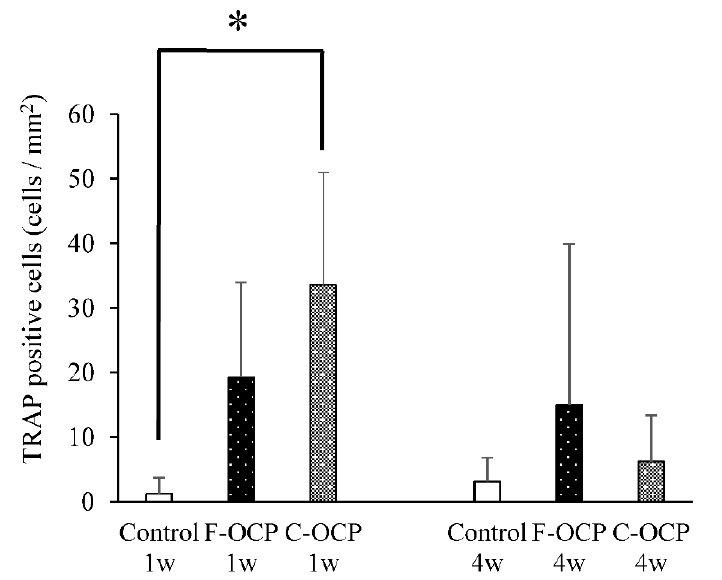
Figure 11. Quantitative analysis of the number of TRAP-positive cells per unit area of intramedul- lary bone in defects treated with no materials (control), F-OCP, and C-OCP at 1 week and 4 weeks post-implantation (* p < 0.05).